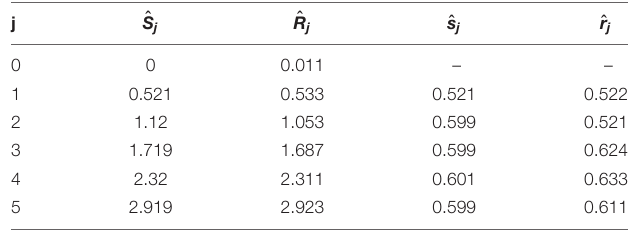
TABLE 1 | One example of data points: the event times, ˆ S j and ˆ R j , are for 5–6 clicks/taps during an IOI step of 0.522–0.6 s (a tempo change from 115 to 100